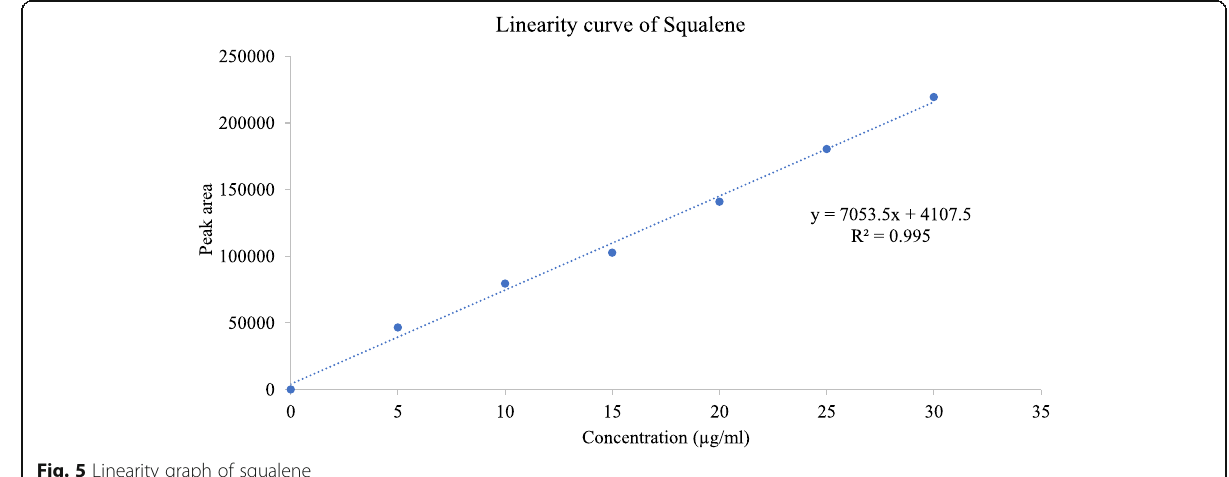
Fig. 5 Linearity graph of squalene